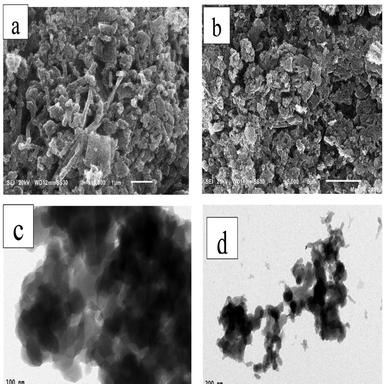
SEM images of (a) C-PANI, (b) PANI; TEM images of (c) C-PANI and (d) PANI.